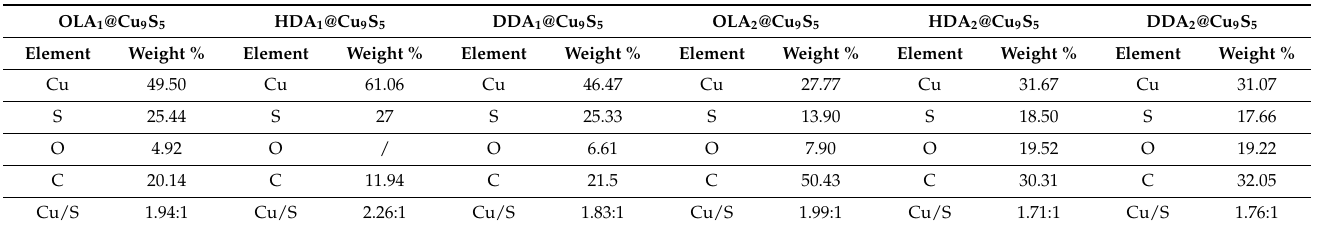
Table 1. EDX analysis of OLA@Cu 9 S 5 , HDA@Cu 9 S 5 , and DDA@Cu 9 S 5 NPs obtained at 190 ◦ C using complex 1 and complex 2.